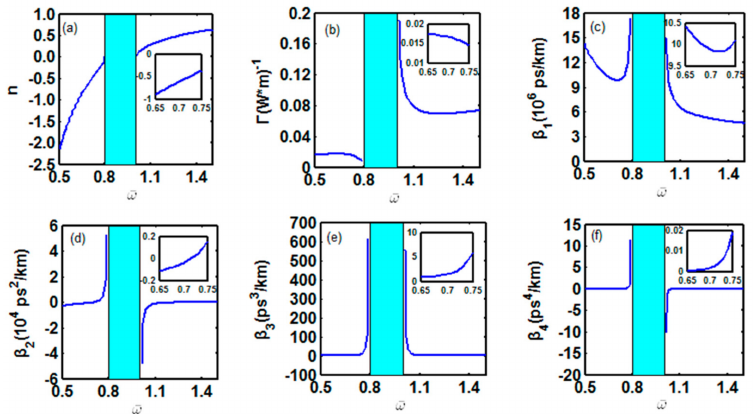
Figure 1. Variations of refractive index, third-order nonlinear coefficient, first-, second-, third-, and forth-order dispersion on ω . Insets are the magnification nearby ω = 0.7. ( a ) Refractive index versus ω ; ( b ) third-order nonlinear coefficient versus ω ; ( c ) first-order dispersion versus ω ; ( d ) second-order dispersion versus ω ; ( e ) third-order dispersion versus ω ; and ( f ) forth-order dispersion versus ω .